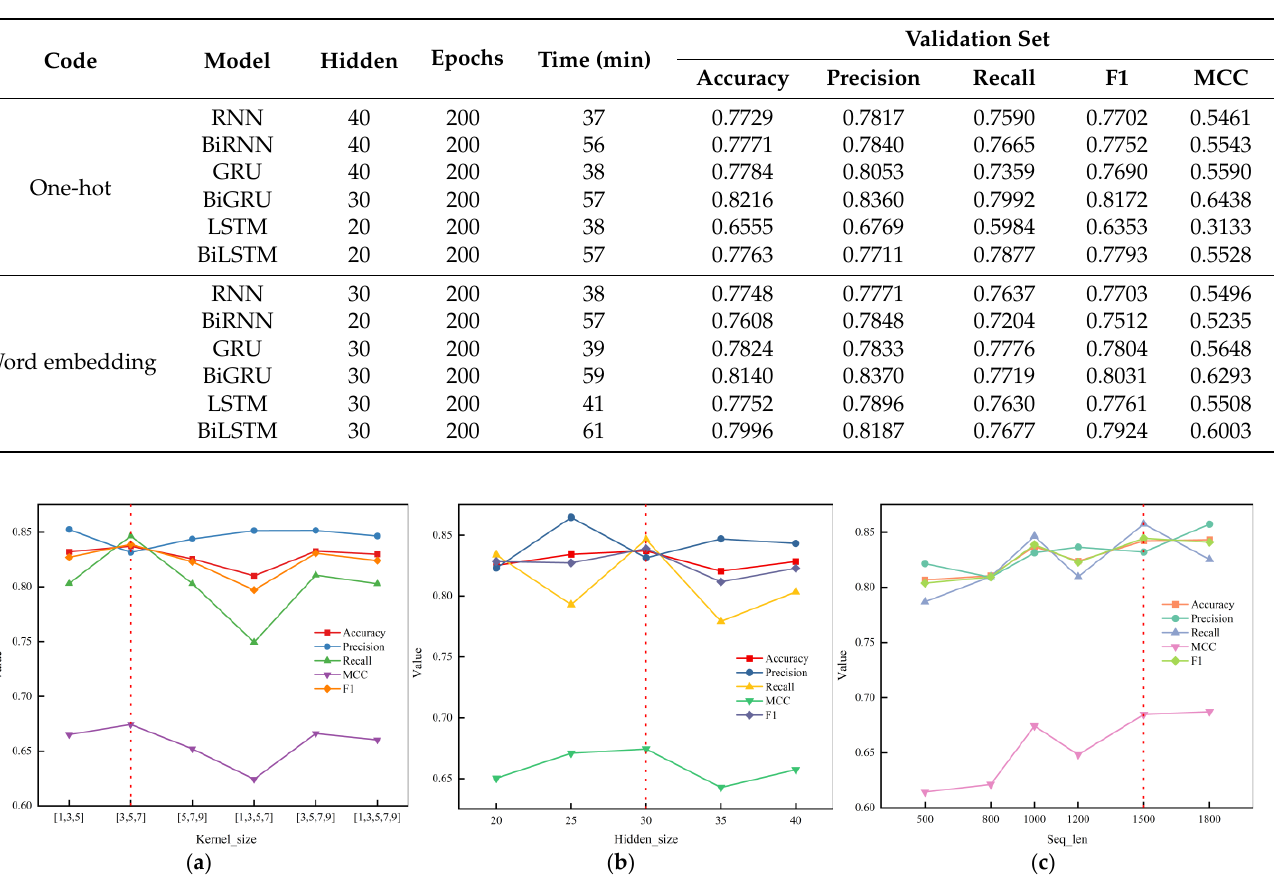
Table 1. Performance of different deep learning models with different coding methods (the Time column indicates the model training time, and the Hidden column denotes the optimal number of neurons in the hidden layer for various models, with the range adjusted from [20,30,40]).